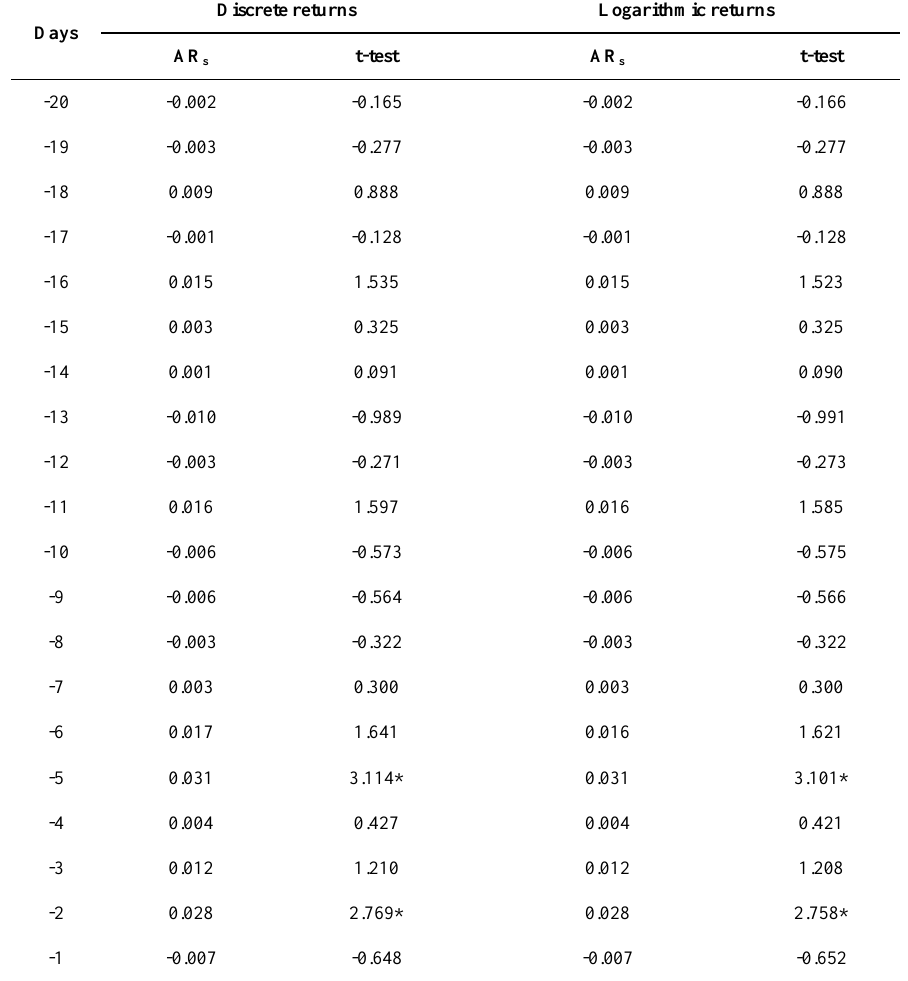
Table2. Abnormal returns (AR s ) & t-values of stocks using both discrete and logarithmic returns for one corporation. Discrete Days